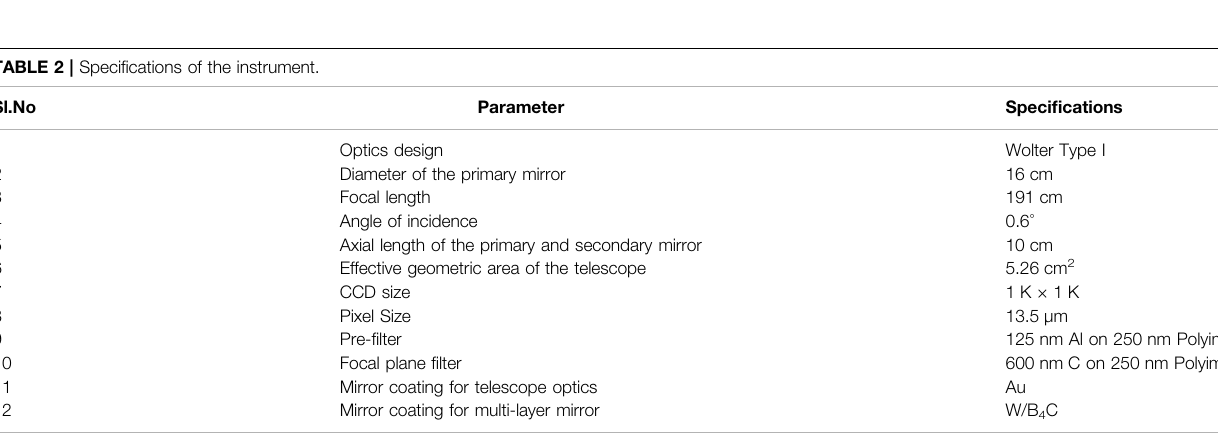
TABLE 2 | Speci fi cations of the